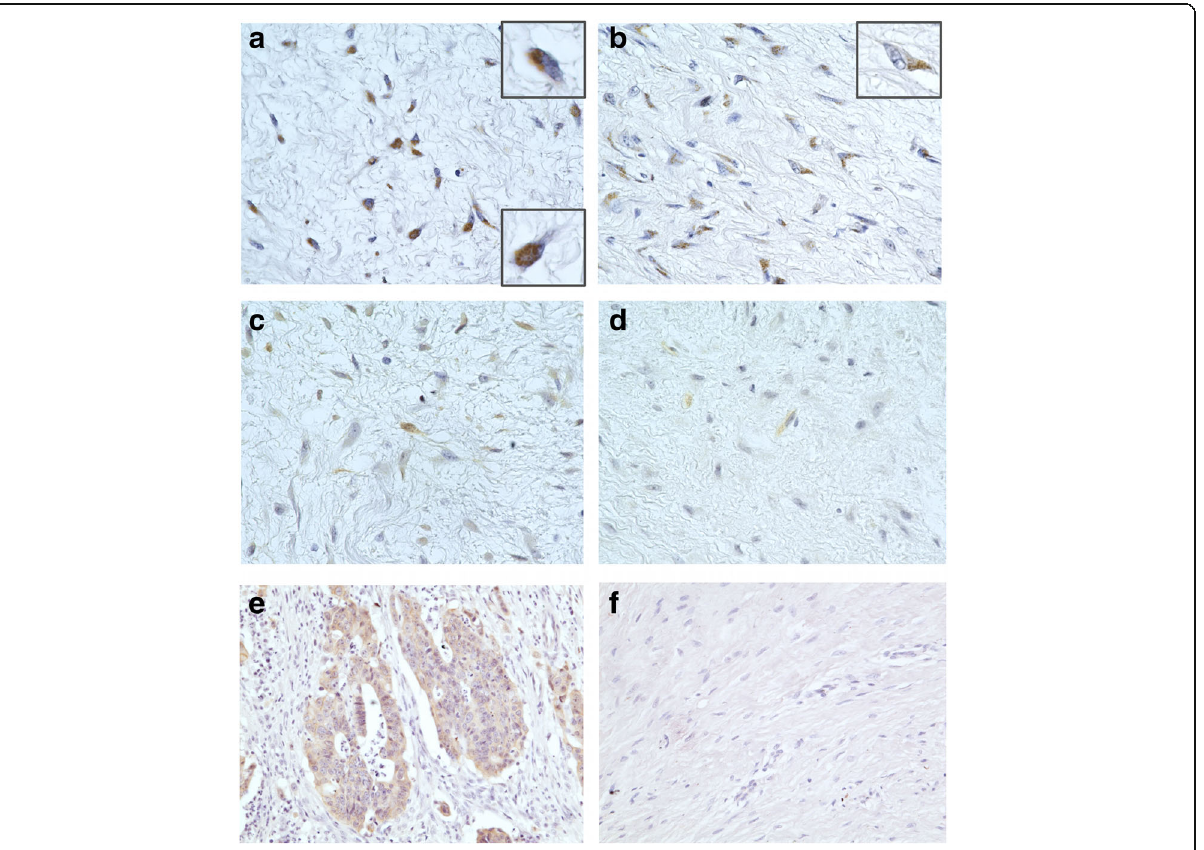
Fig. 1 Immunohistochemical staining for β -catenin and non-phospho β -cateninRepresentative images were shown with staining for β -catenin ( a and b ) and non-phospho β -catenin ( c and d ). Nuclear and cytoplasmic staining was observed in a and c (a: upper right inset; higher magnification of cytoplasmic staining, a: lower right inset; higher magnification of nuclear staining). Only cytoplasmic staining was observed in b and d (b: upper right inset; higher magnification of cytoplasmic staining). Positive staining was observed in human colon carcinoma tissue ( e ). A representative case of fibroma of tendon sheath showed negative staining ( f ). (counterstained with hematoxylin; original magnification: a - d ; ×400, e-f;